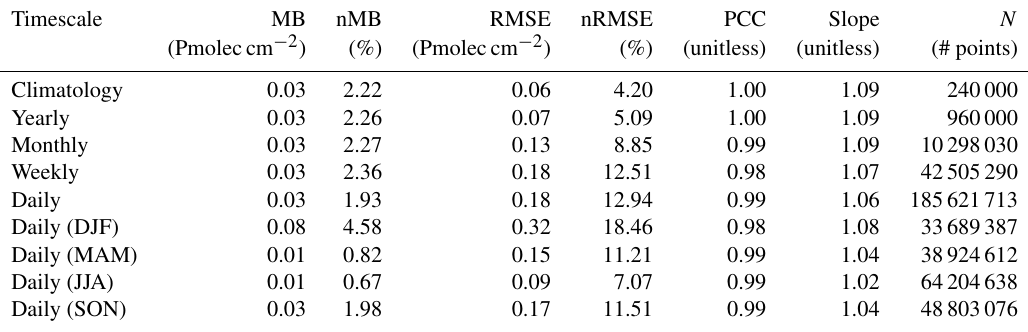
Table B1. Statistics of TROPOMI TrC-NO 2 PAL products compared to OFFL + RPRO (taken here arbitrarily as the reference). Timescale